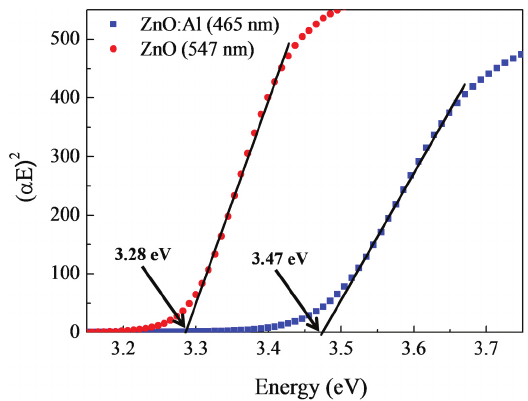
Figure 6. The energy gap of the ZnO:Al and intrinsic ZnO films estimated by the extrapolation of the linear part of the ( ahν ) 2 versus hν plots.